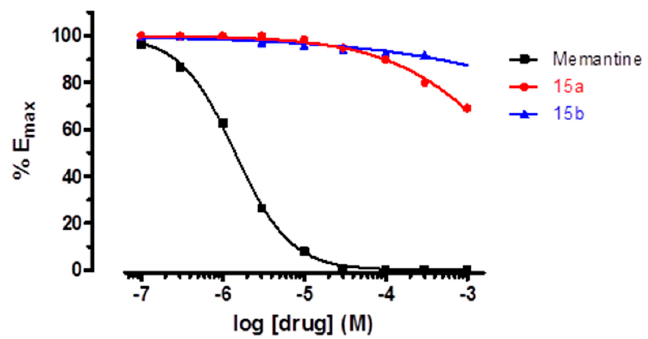
Figure 3. Dose–response curves for memantine and compounds 15a – b in NMDA receptors.